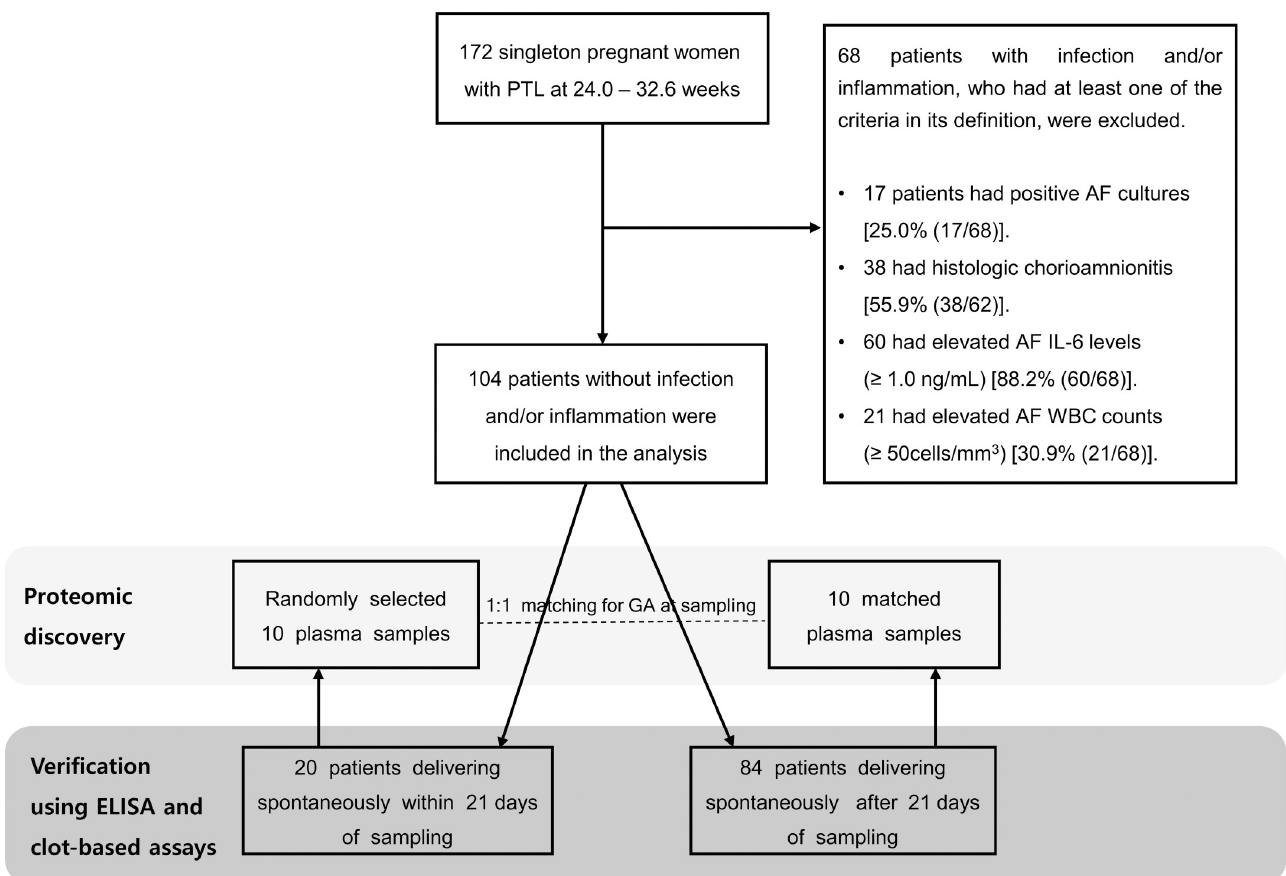
Fig 1. Flow-chart outlining the study design with inclusion and exclusion of patients.